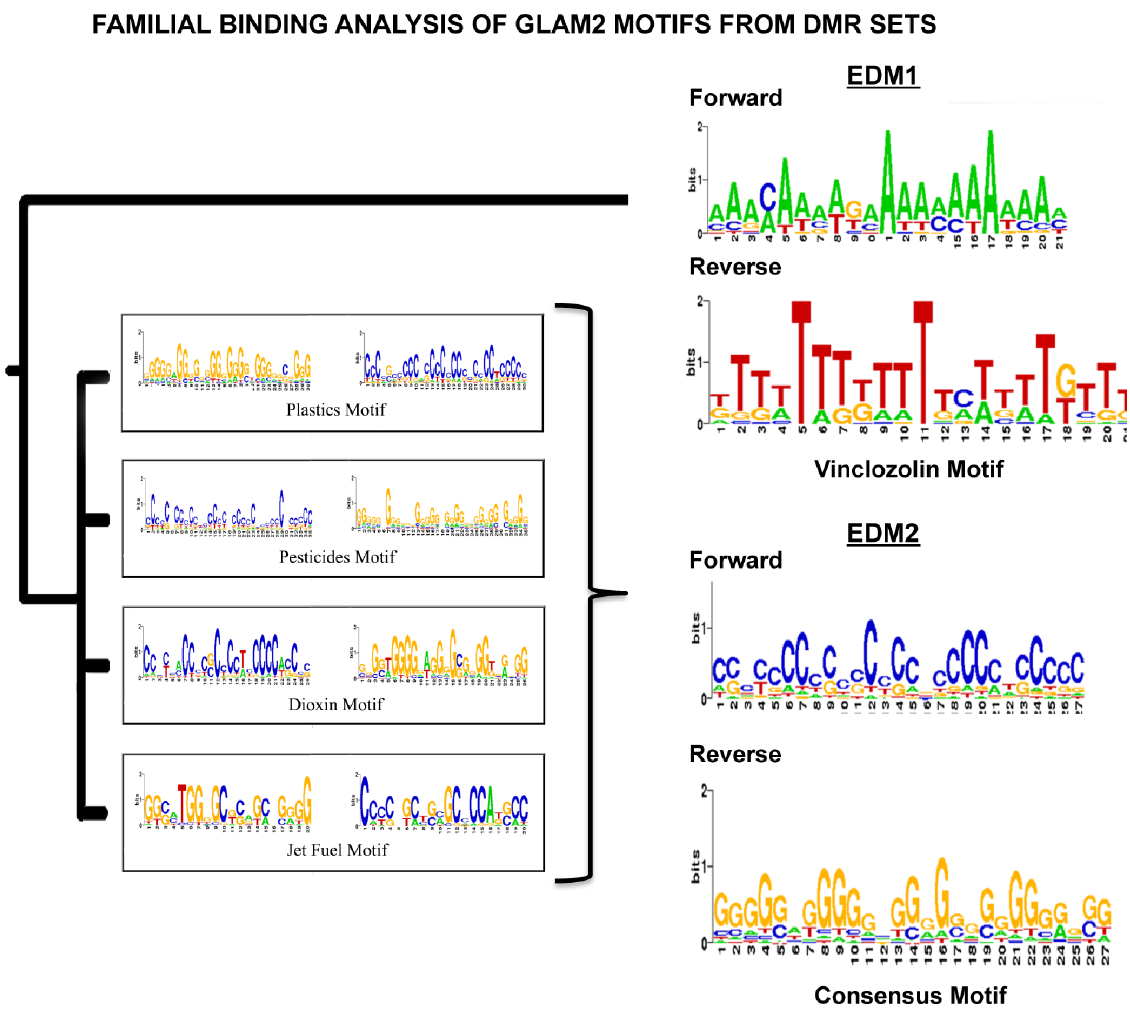
Figure 1. Exposure specific DMR set DNA sequence motifs using GLAM2 and the familial binding tree. The forward (left) and reverse (right) sequences for each motif are presented. The consensus EDM2 motif is presented.